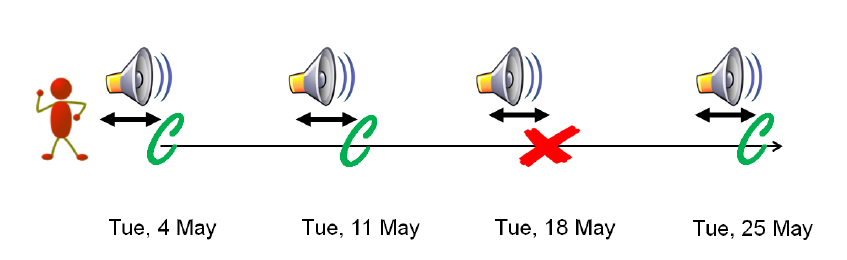
Figure 1. Example of case-crossover design, where exposure (noise level) is assessed in case (red) and control (green) event nights for an individual.